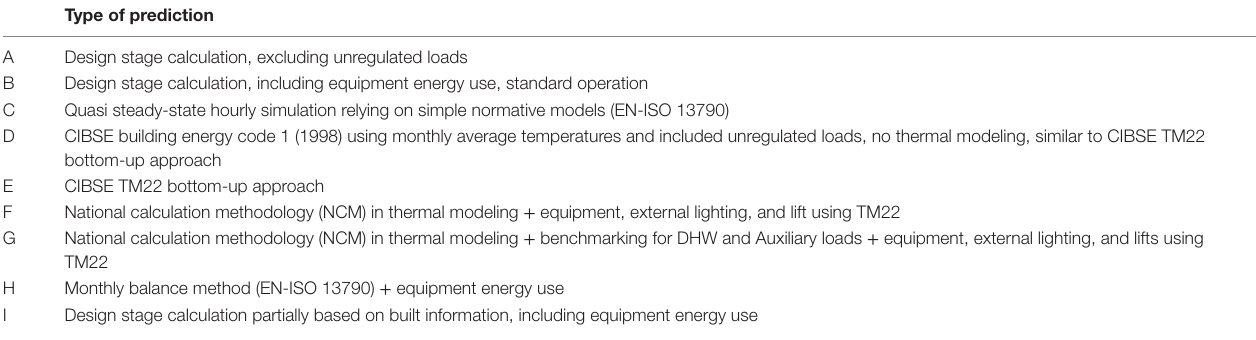
TABLe 2 | Type of prediction used in the reviewed literature case studies, denoted by a letter.